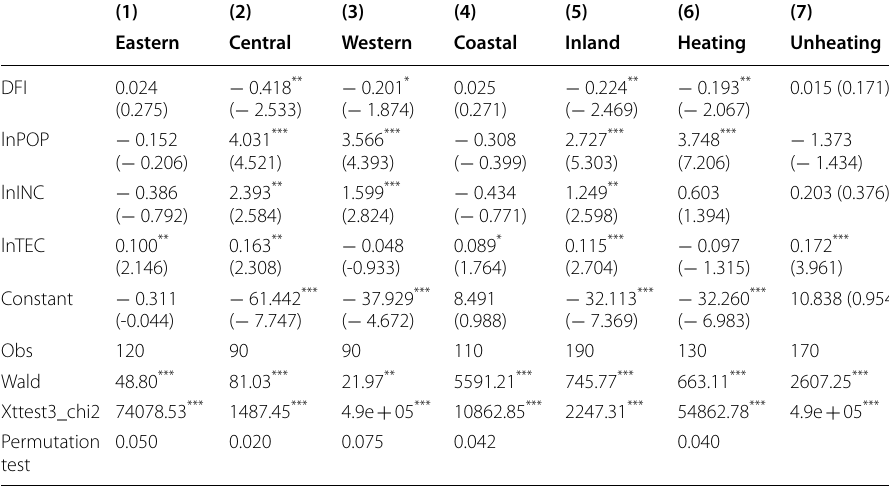
The values in parentheses represent the t-statistics * , ** , *** imply the significance at the 10%, 5%, and 1% levels, respectively. The number of bootstraps is